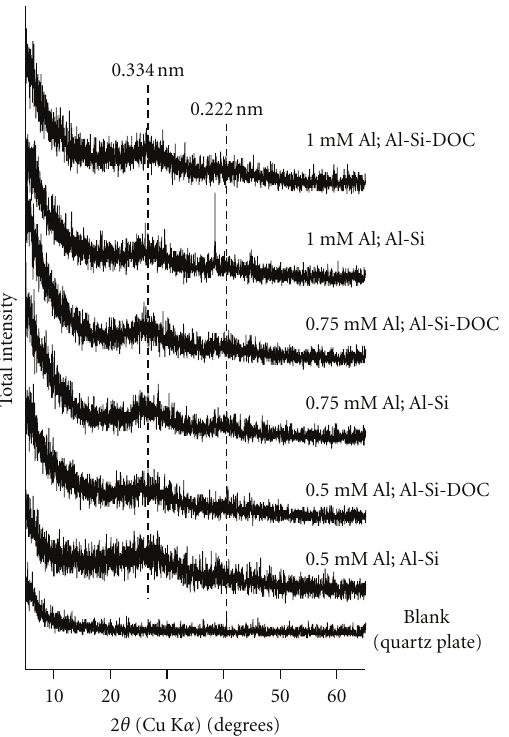
Figure 3: X-ray di ff raction patterns for solids derived from Al-Si and Al-Si-DOC solutions with 0.5, 0.75, and 1.0 mM Al; 0.5 mM Si; 0 or 6mg/L